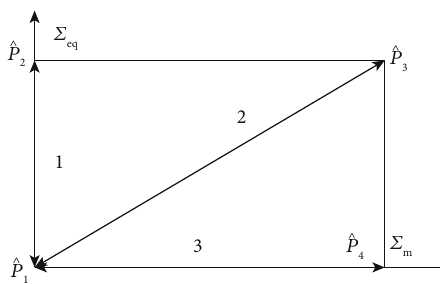
Figure 4: Critical cyclic loadings of the considered load